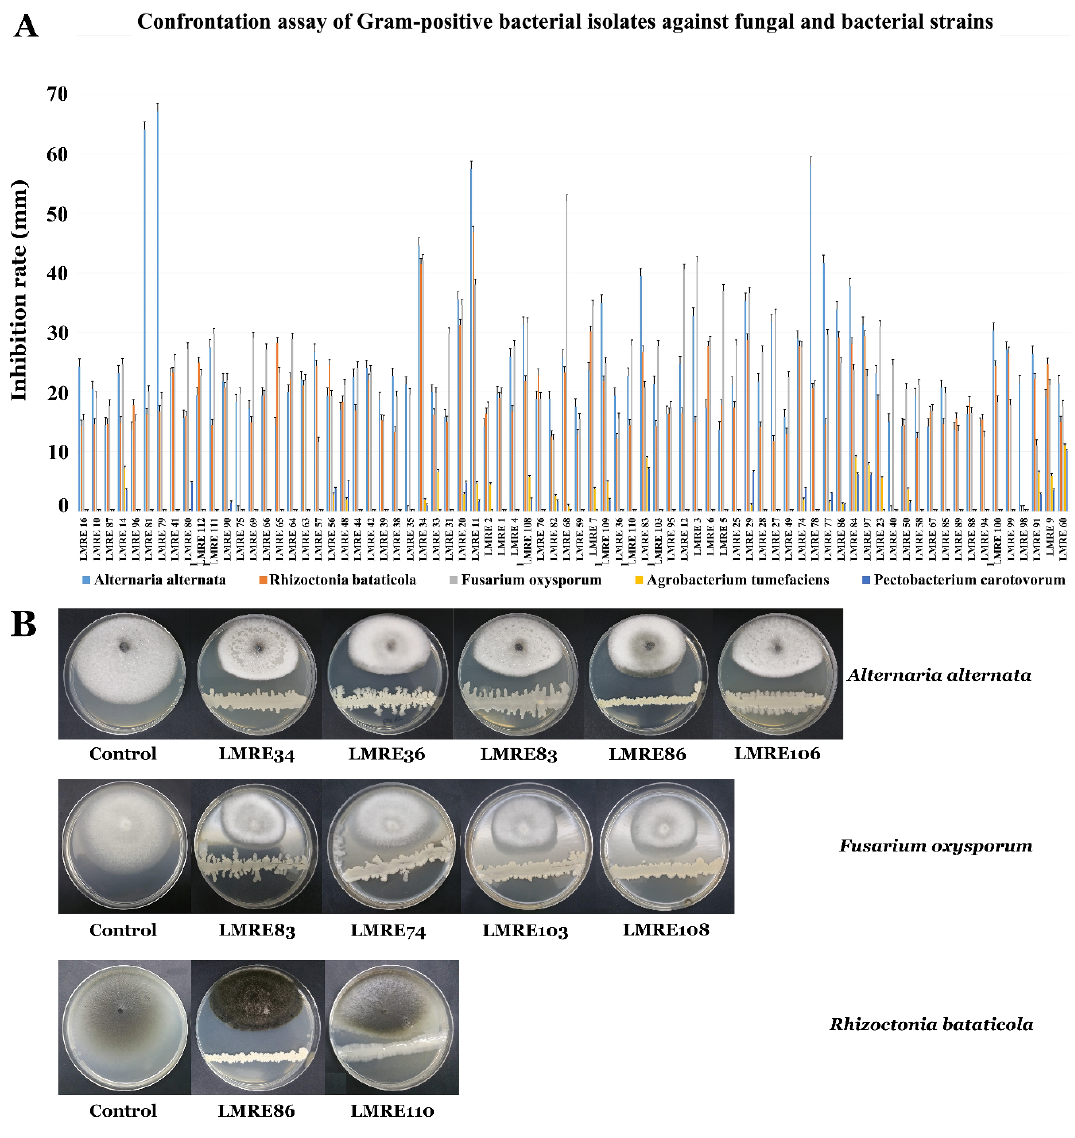
Figure 6. (A) Bar-chart of confrontation assay of Gram-positive bacterial isolates against fungal strains and bacterial isolates. (B) Confrontation test of Alternaria alternata against bacteria.